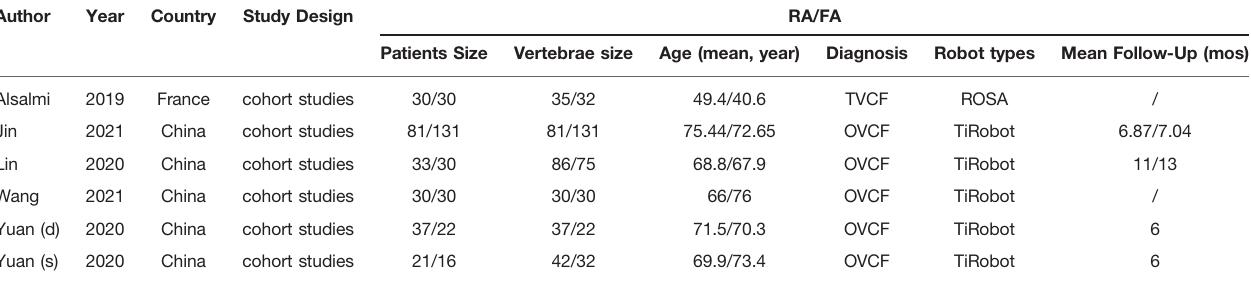
TABLE 1 | Demographics and characteristics of included studies.